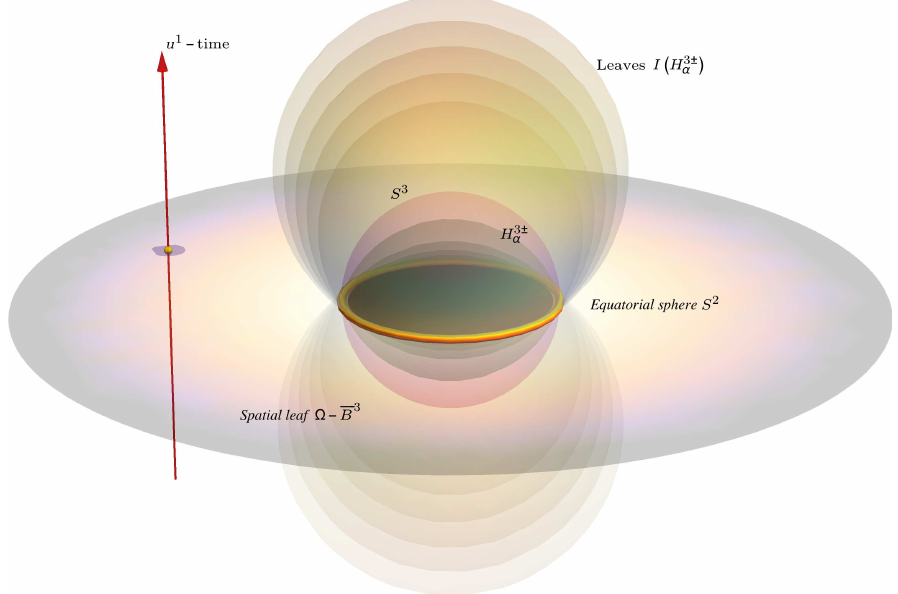
Figure 5. Leaf space in spacetime and π -foliation ̂O . Black disc: open ball B 3